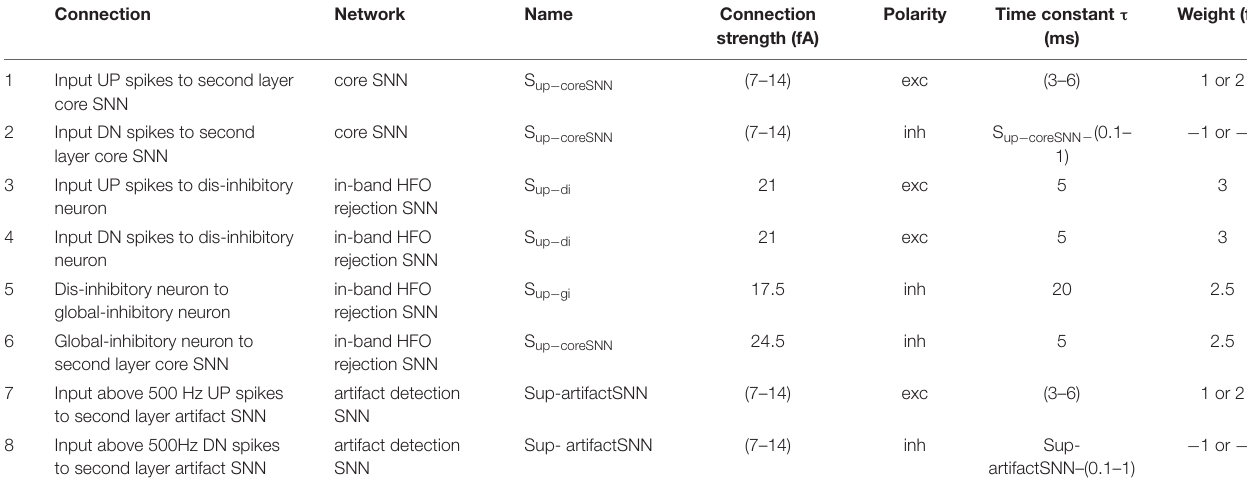
FIGURE 2 | The SNN to detect HFO in iEEG, ECoG and the scalp EEG. The input to our SNNs are the UP and DN spike trains generated by converting the signals into spikes. The core SNN architecture (green box, used for iEEG) for HFO detection consists of input neurons (gray) receiving the input UP-DN spikes from the filtered signal in HFO band (ripple band and FR band for iEEG, FR band for ECoG, and ripple band for scalp EEG). These inputs project to a second layer of neurons (green) with different synaptic parameters. The core SNN can also interact with the in-band artifact rejection SNN (purple box, added for ECoG). For this interaction, the inputs of the core SNN are projected to the dis-inhibitory neuron (purple) using excitatory synapses. This neuron projects inhibitory synapses to a global-inhibitory neuron (orange), which is continuously inhibiting the second layer neurons. The role of the interneuron and the inhibitory neuron is to avoid the false detection of sharp transients. The artifact rejection SNN (yellow box, added for scalp EEG) consists of input neurons (gray) receiving the input UP-DN spikes from filtering the signal above 500 Hz. These inputs project to a second layer of neurons (yellow) with different synaptic parameters. Panels modified from Burelo et al. (2021, 2022) and Sharifshazileh et al. (2021). TABLE 2 | Synapse parameters of the SNNs for HFO